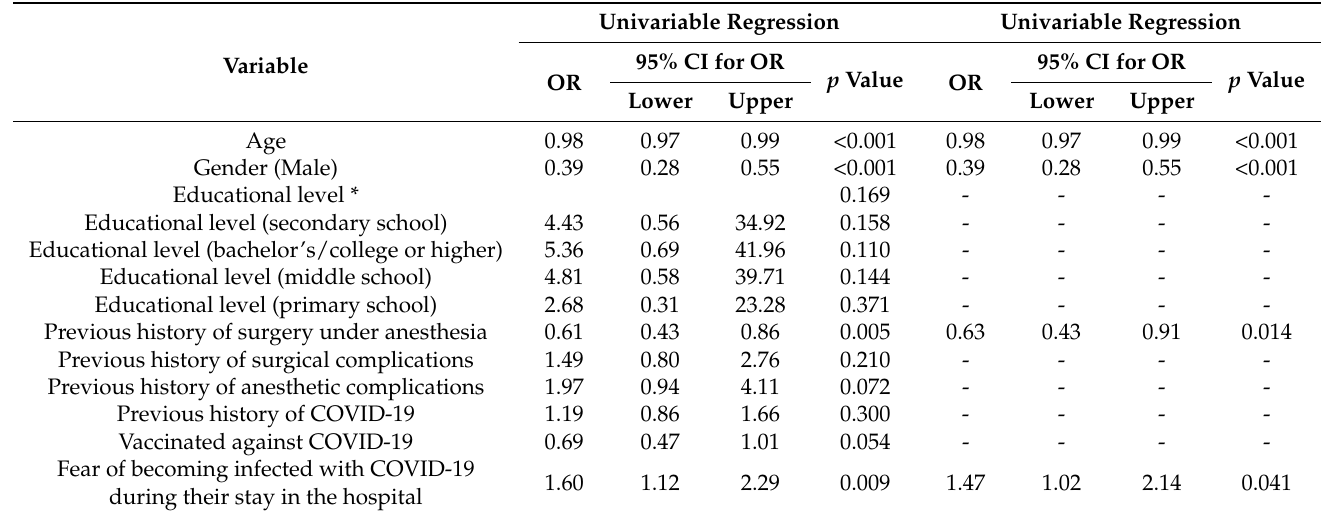
Table 5. Univariable and multivariable regression analysis for factors correlating with high preopera- tive